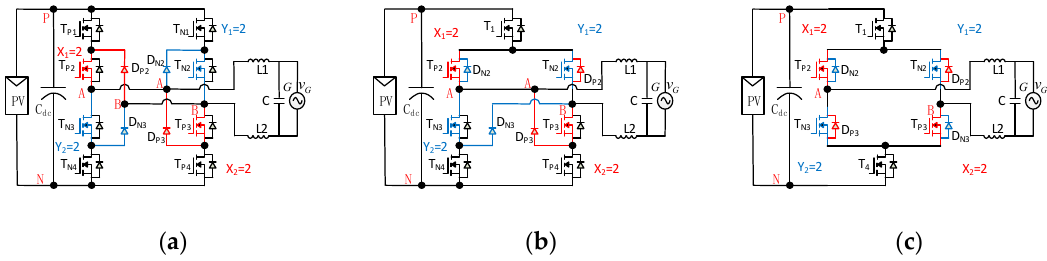
Figure 18. Four topologies derived from X 1 = 2, X 2 = 2, Y 1 = 2, and Y 2 = 2. ( a ) R11 (new); ( b ) R12 (new); ( c ) R13 [17].